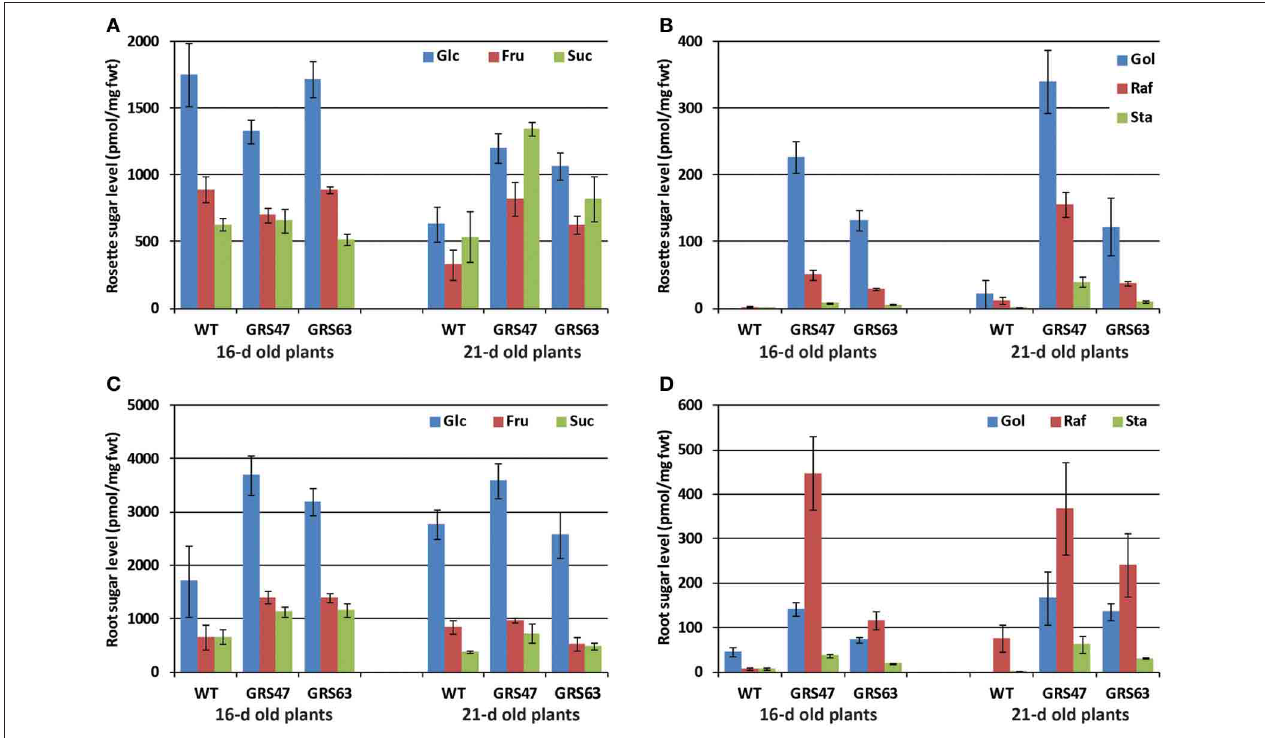
FIGURE 5 | Soluble carbohydrates in rosettes and roots of WT and GRS47 and GRS63 grown for 16 and 21 d on sterile MS media in vertically oriented plants. (A) Glc, Fru, and Suc in the rosettes of each line at the indicated number of days, (B) Gol, Raf, and Sta in the same rosettes as